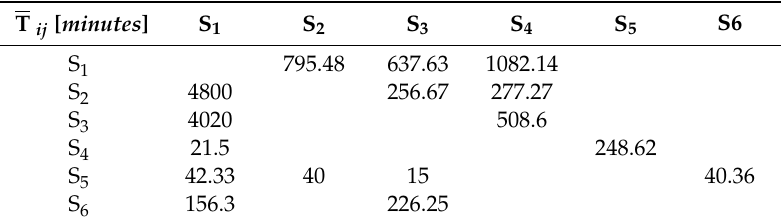
Table 6. Average conditional durations of the semi-Markov process states.